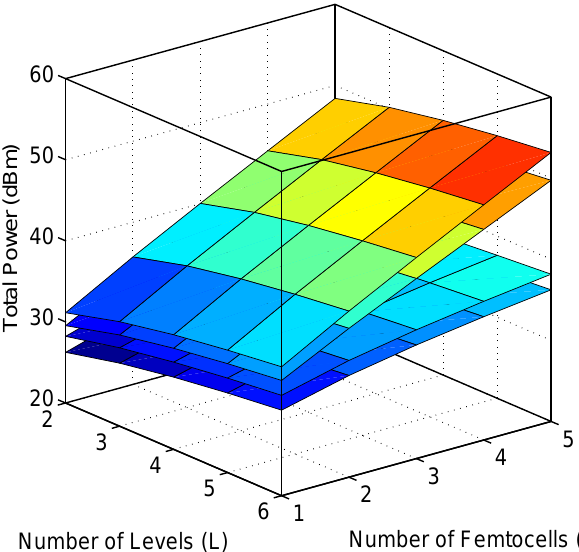
Figure 3. The upper and lower bounds for the total power consumption. The four surfaces in the plot are (from top to bottom): the looser upper bound, the tighter upper bound, the tighter lower bound, and the looser lower bound.